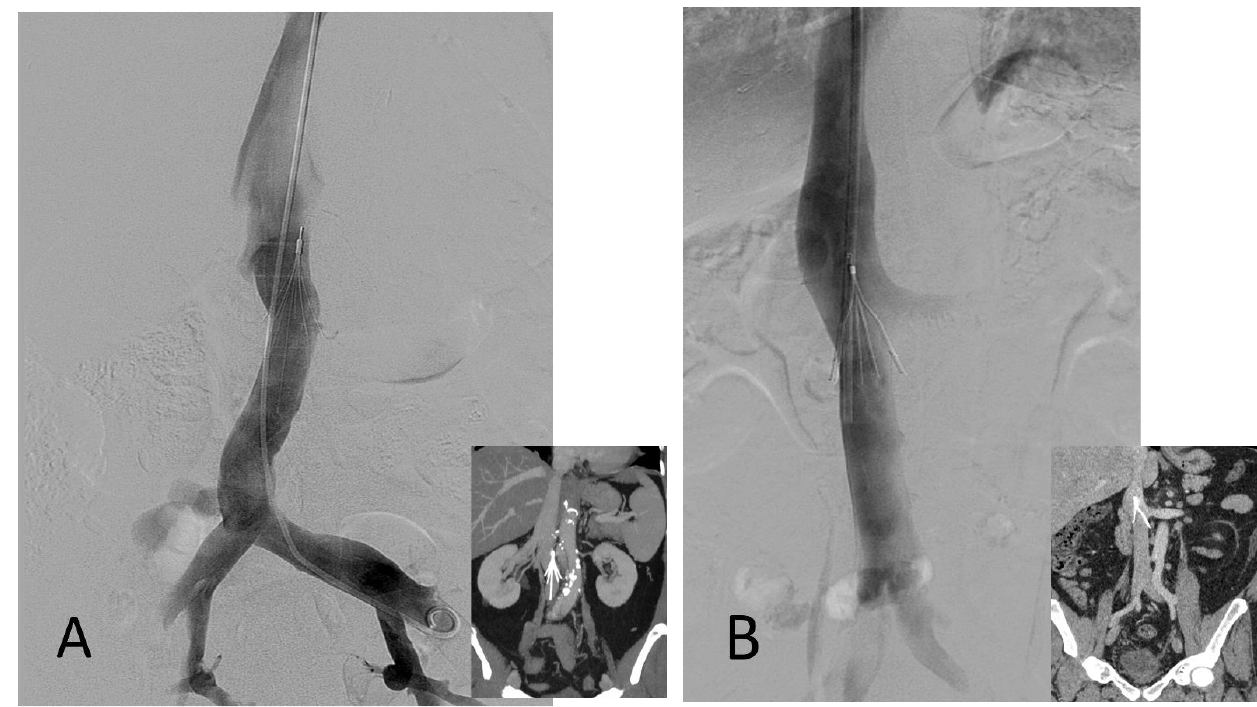
Figure 3. ( A ) ALN filter, cavography with the filter and CT coronal view. ( B ) Celect filter cavography and CT coronal view.